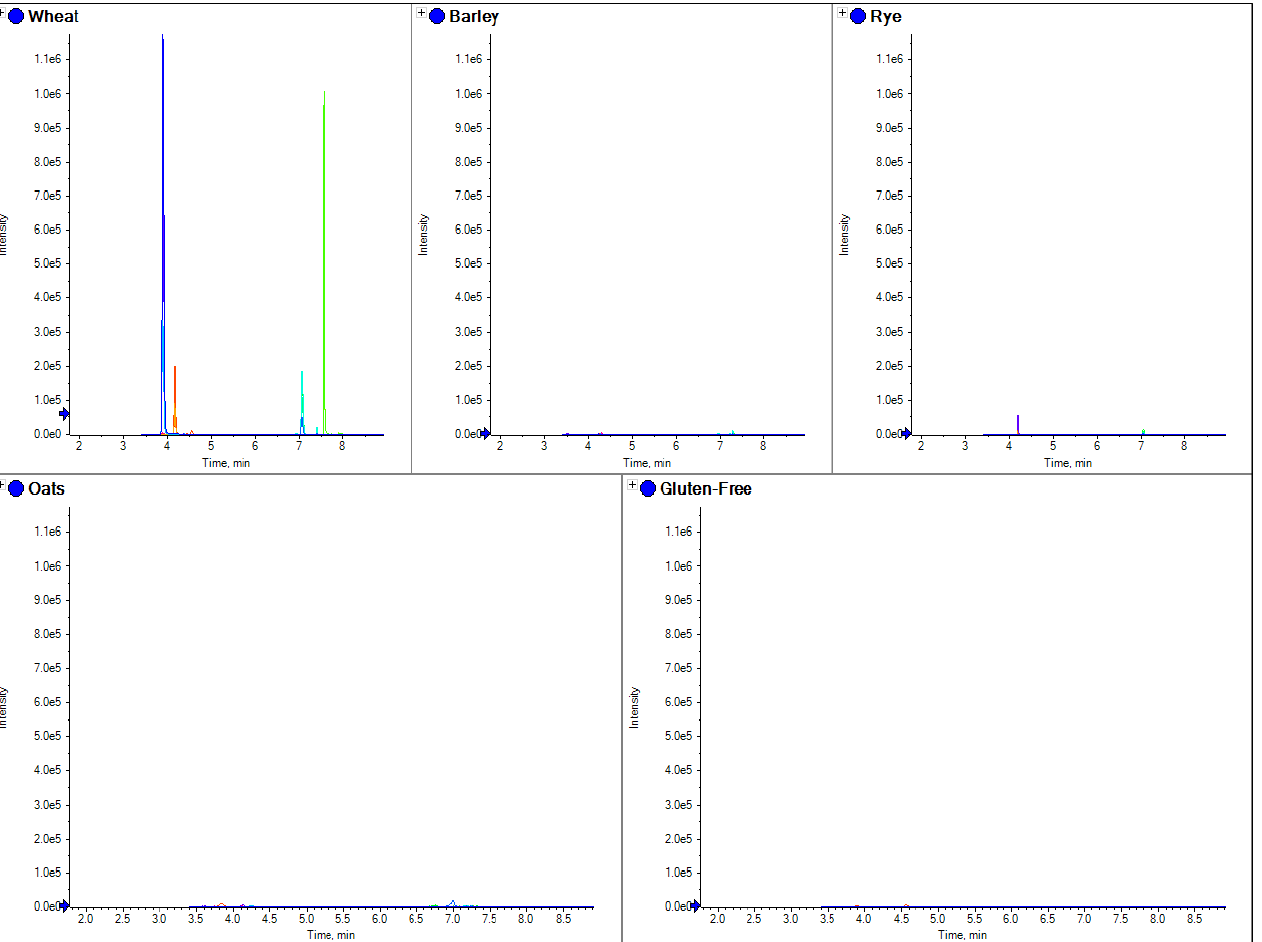
Figure 6. The comparison of separate extracts from barley, wheat, rye, oats and gluten-free flour. Here four separate peptide chromatograms for wheat marker peptides (obtained from the theoretical digestion of glutenin) have been shown for the extracts of each